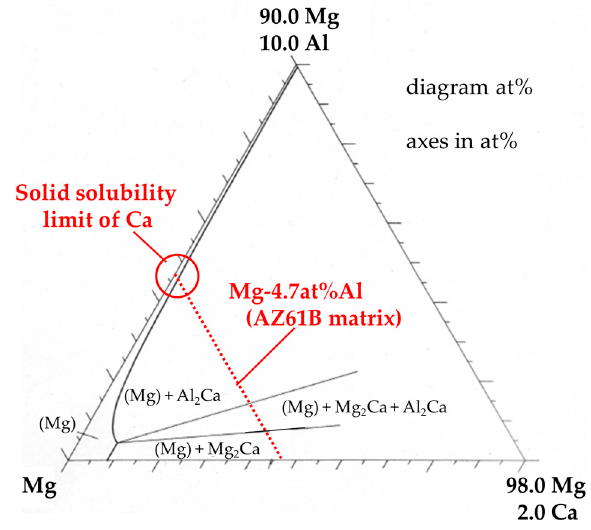
Figure 8. Isothermal section of the Mg–Al–Ca ternary system in Mg-rich corner at 450 °C.